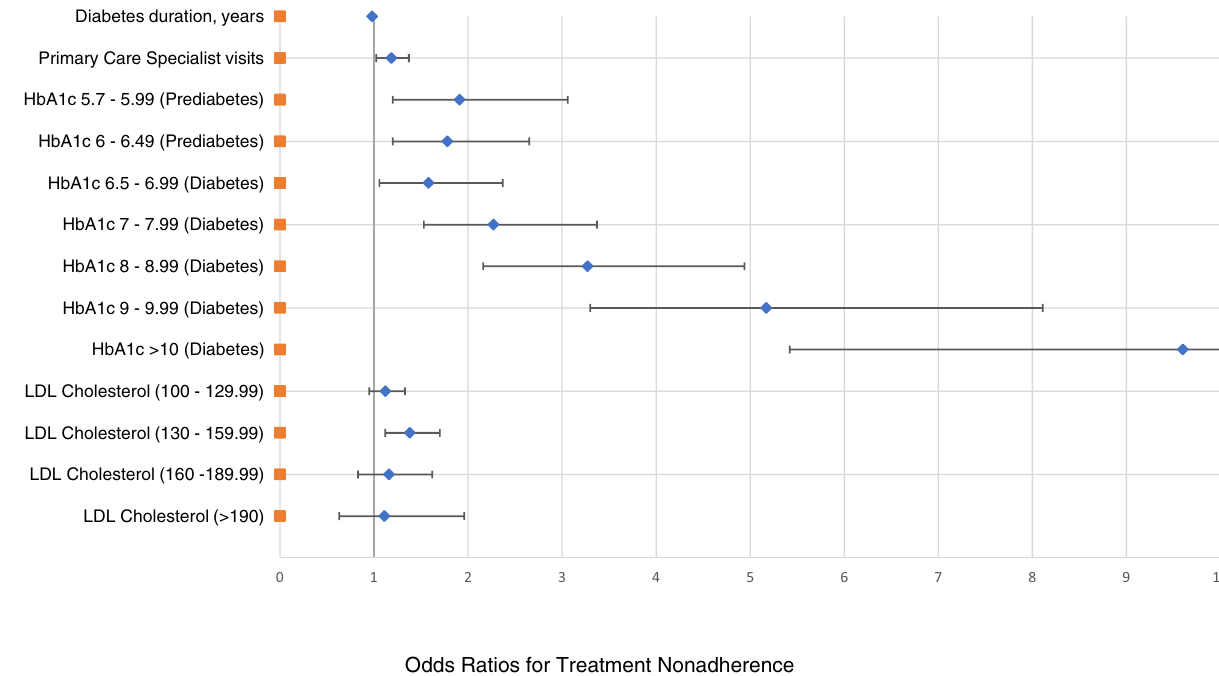
Figure 2. Forest plot for primary outcomes and significant covariates on treatment nonadherence in type 2 diabetes patients with comorbid